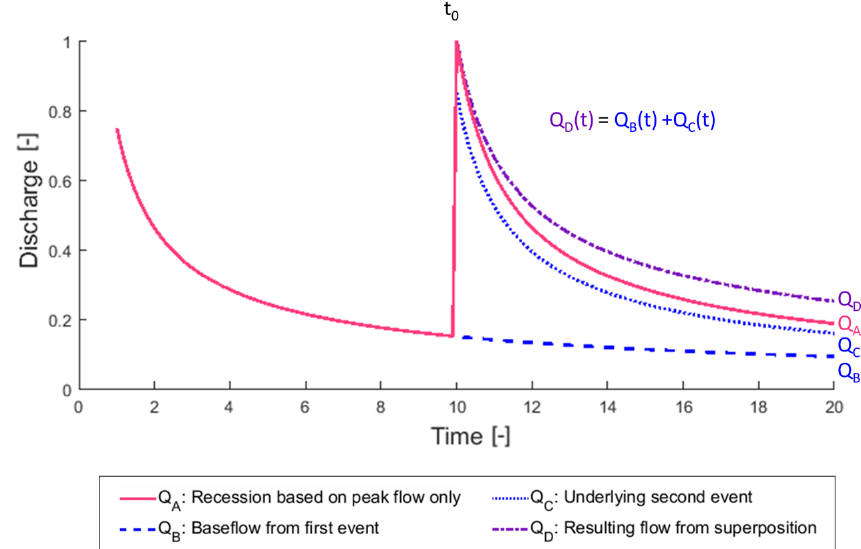
Figure 2. Conceptual model of identical recession events only dependent on the initial dimensionless flow ( Q A representing Case 1) and superposition of events to include antecedent conditions (summation of the blue-dotted line – Q C – and blue-dashed line – Q B – resulting in the superposition of the flow in the purple dashed-and-dotted line – Q D – representing Cases 2 and 3). By superimposing the antecedent flows ( Q B ) on the underlying event ( Q C ), the effective falling limb ( Q D ) is less steep than the non-superimposed falling limb ( Q A ). Time is expressed in dimensionless units and arbitrary values.